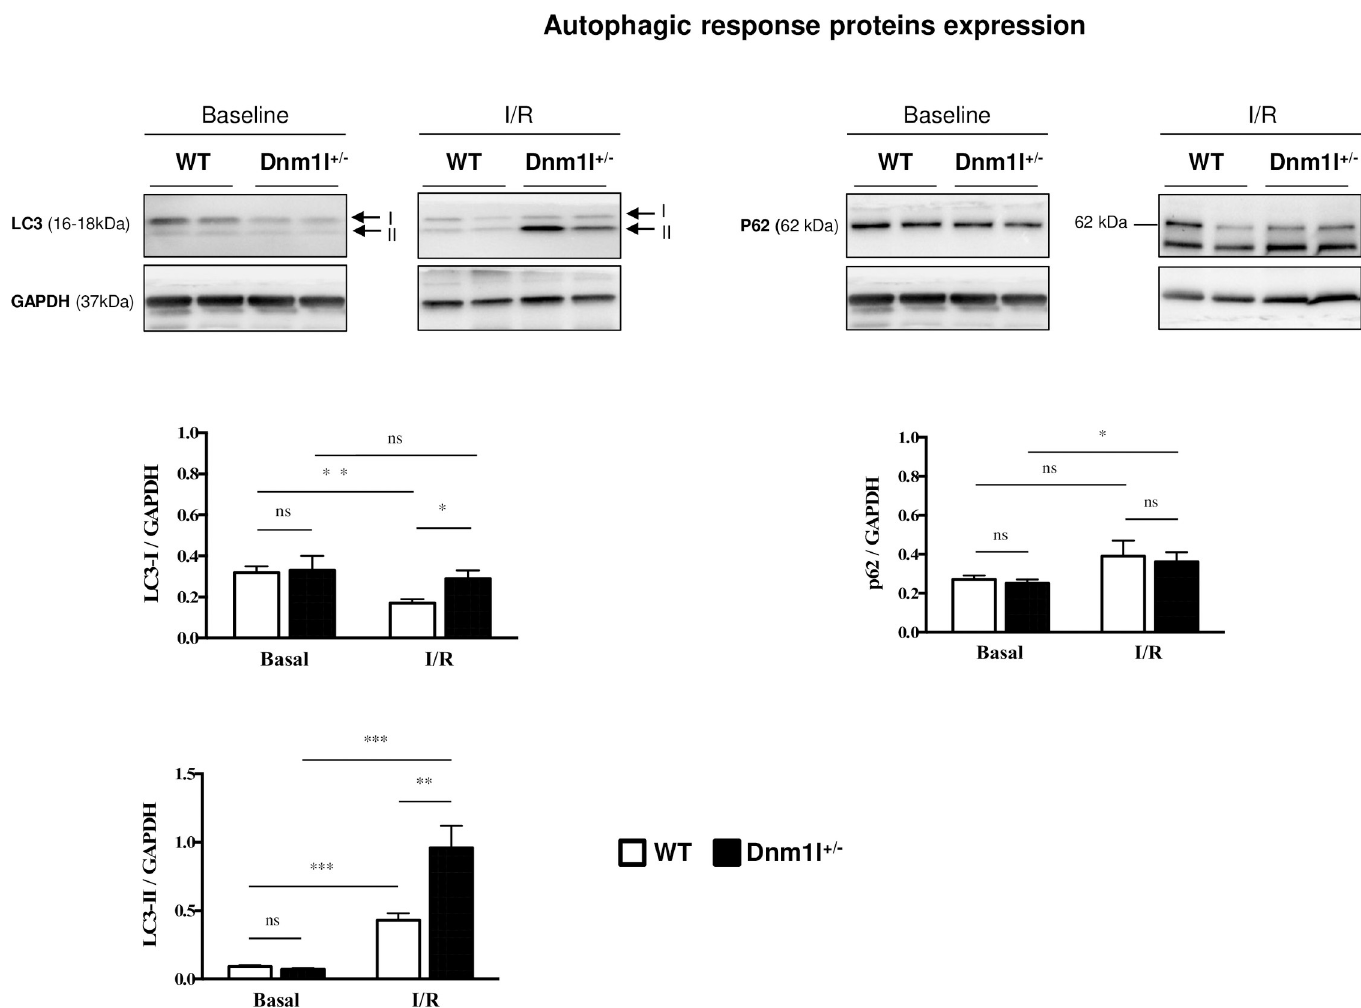
Fig 5. Representative immunoblot of autophagic response proteins. Autophagy levels were assessed by quantitative analysis of autophagy markers LC3-II and p62 in Dnm1l +/- and WT mice at baseline and after ischemia/reperfusion (I/R). The results are expressed as ratios of protein band densities of LC3-II and p62, (n = 6–10 per group). GAPDH was used as a loading control. Values are mean ±